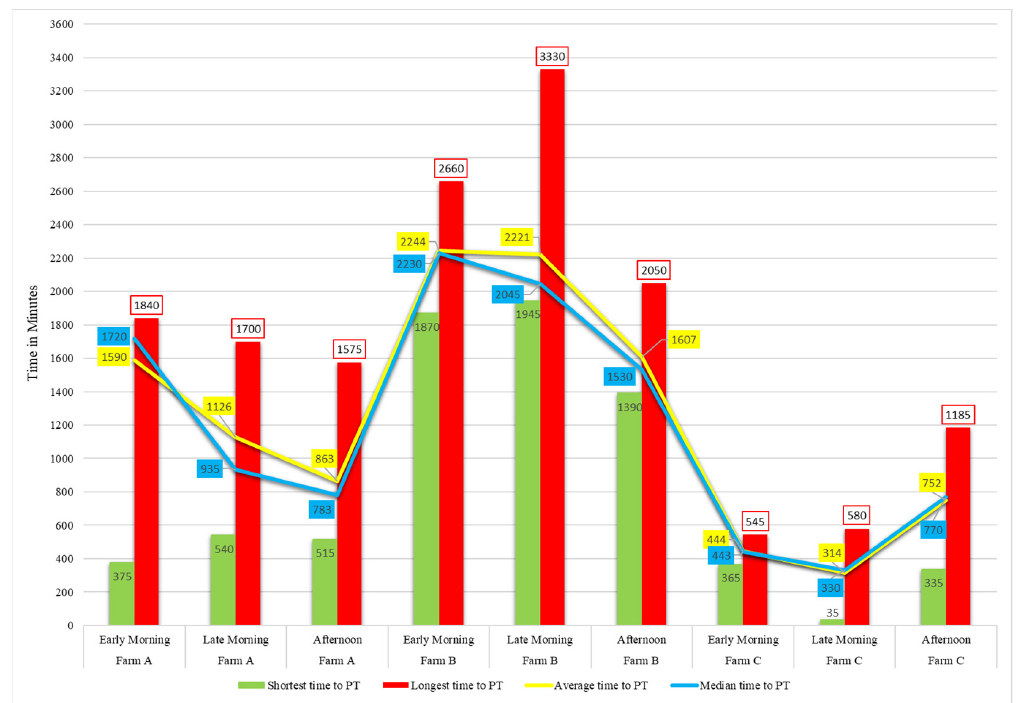
Figure 6. Time in minutes to reach PT = 6 °C on Western Cape farms. Source: [13].